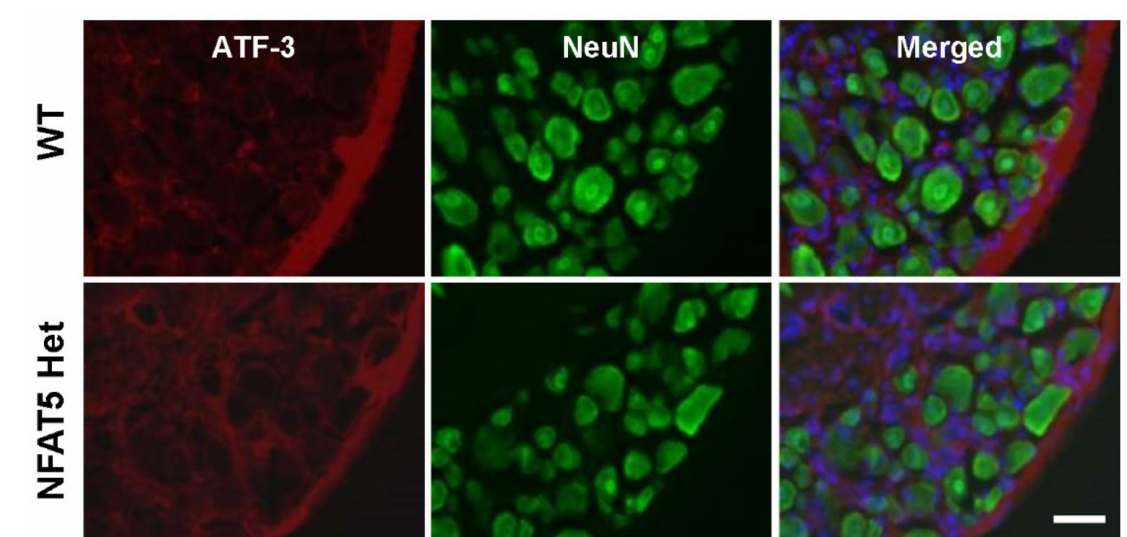
Figure 2. Formalin-induced ATF3 expression in dorsal root ganglia of WT and NFAT5-Het mice. At 1 h post-formalin injection, dorsal root ganglia (DRG) at lumbar (L) 3–5 from WT and NFAT5-Het mice were prepared and co-immunostained with anti-ATF3 (a neuronal injury marker) and anti-NeuN antibodies (a neuronal marker). Scale bar: 50 µ